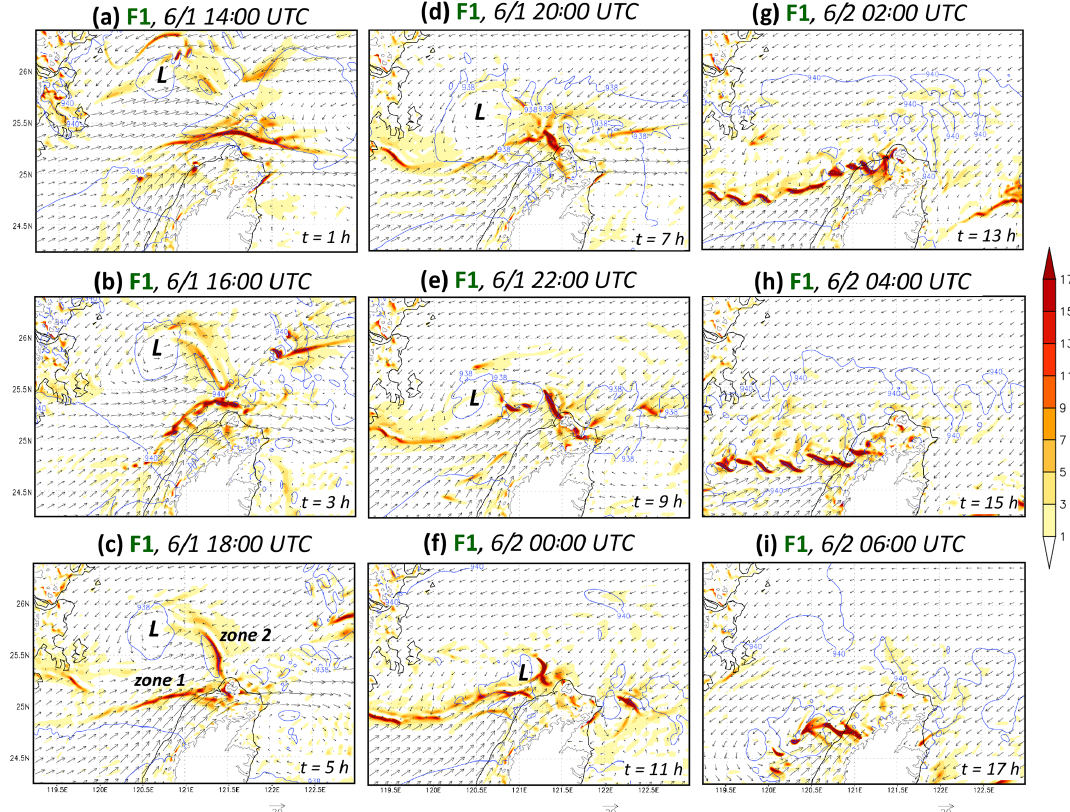
Figure 14. Model pressure (hPa, isobars every 2hPa), horizontal winds (ms − 1 , reference vector at bottom), and convergence (10 − 4 s − 1 , color, divergence omitted) at the height of 575m near northern Taiwan every 2h from (a) 14:00UTC on 1 June to (i) 06:00UTC on 2 June 2017 in the F1 experiment. The height contours at 575m are also plotted over land (gray), and convergence zone 1 and 2 (see text for details) are also marked in (c)